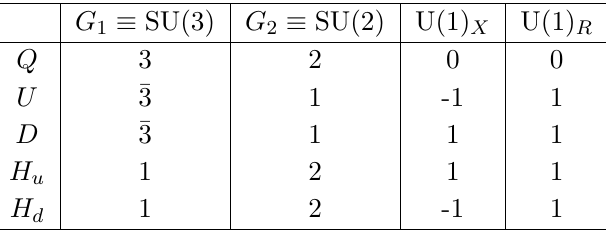
Table 1 . Charge assignments of the chiral super(cid:12)elds in the toy model. The global symmetries help us to disregard complexities due to the gaugino